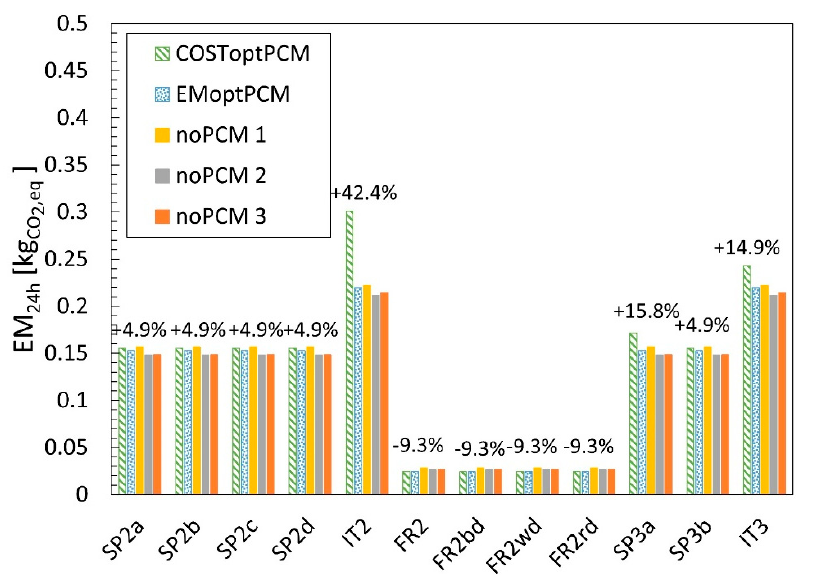
Figure 9. Daily carbon emission of the cabinet refrigerator working with the scheduled hysteresis obtained by the running cost optimization performed in Maiorino et al. [44]. The percentage values above each bar represent the difference between the carbon emission calculated with a hysteresis scheduling which optimizes daily running cost, and the minimum carbon emission obtained simulating the refrigerator without PCM with a fixed hysteresis.